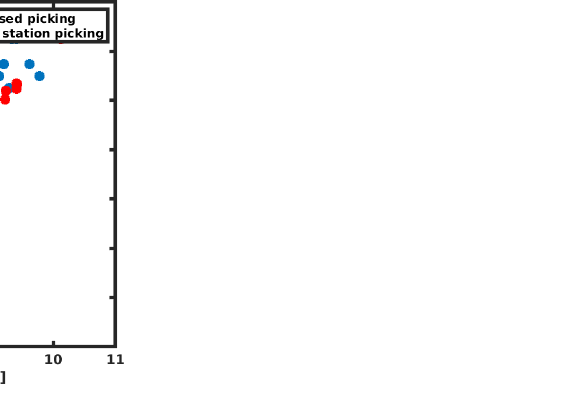
Figure 6. Wadati plot for the collected events for INGV bulletin picking and for our picking method.